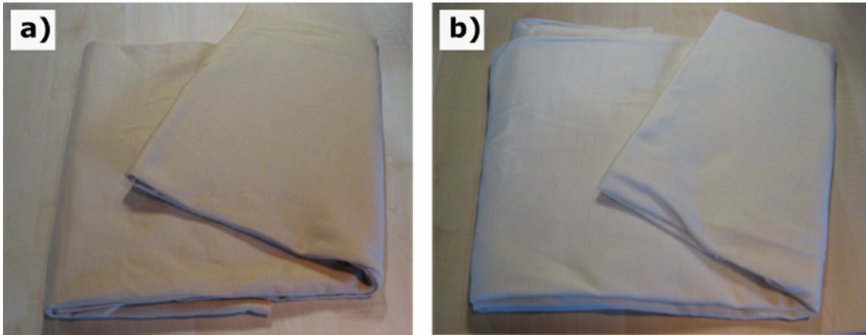
Figure 1. Weft-knitted fabrics of ( a ) soy protein (SP) ( b ) chitin fibers.